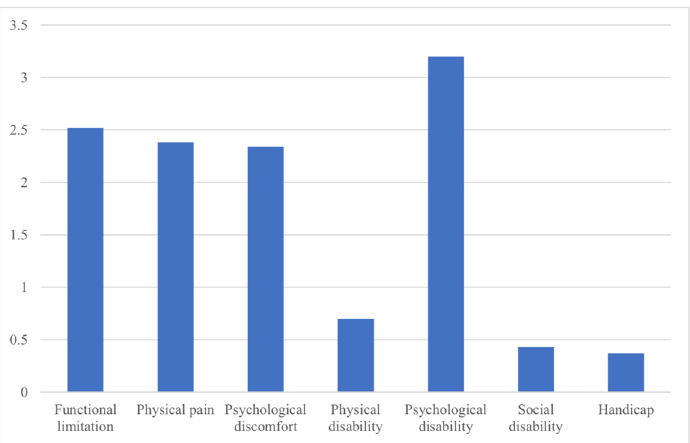
Figure 1. Dimensions of the OHIP-14 questionnaire.